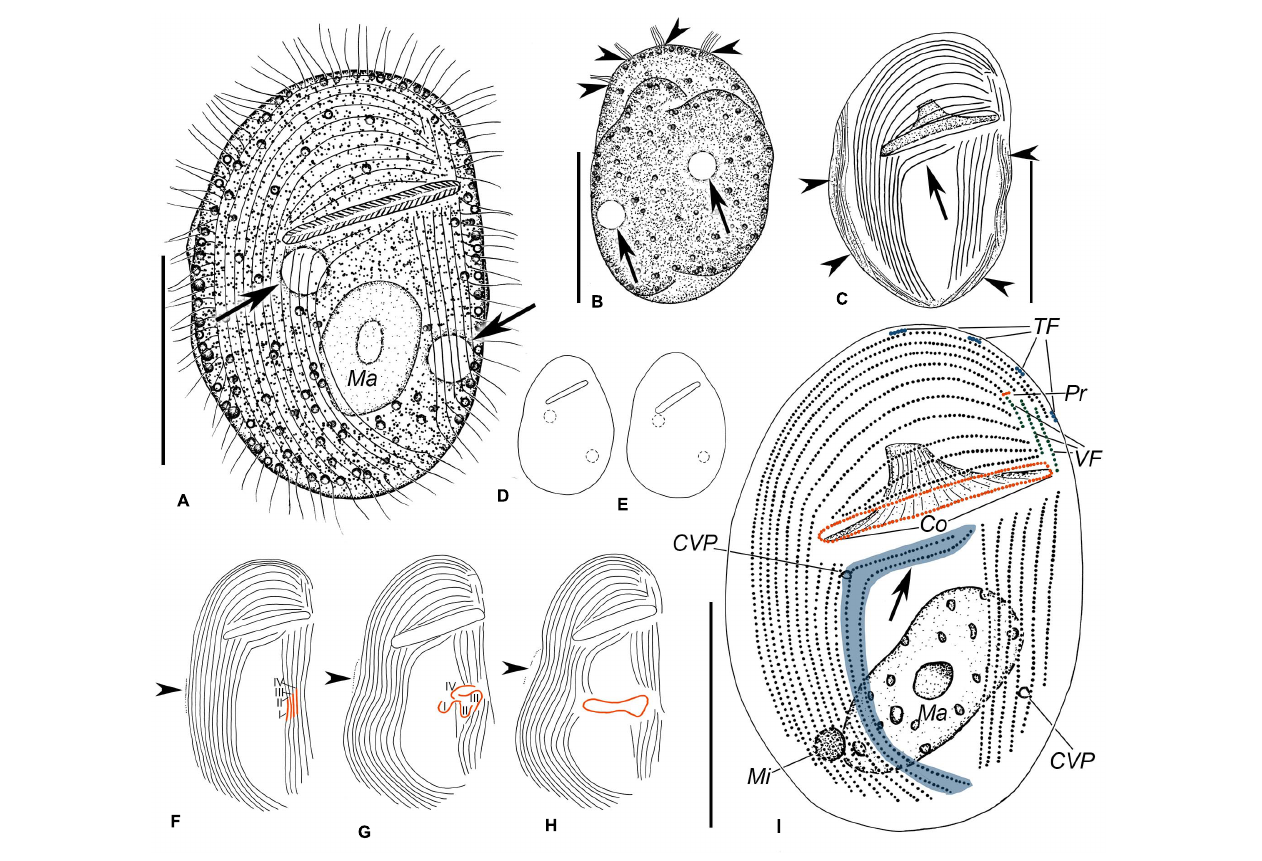
FIGURE 1 | Illustrations of Gastronauta paraloisi sp. n. from life (A,B,D,E) and after protargol-staining (C,F–I) . (A) Ventral view of a representative specimen. Arrows mark contractile vacuoles. (B) Dorsal view. Arrows indicate contractile vacuoles and arrowheads point to terminal fragments. (C) Ventral view of general ciliature; arrowheads denote the fibers along the cell margin after protargol-staining, and arrow shows the two curved postoral right kineties. (D,E) Body shape variations. (F–H) Several stages of morphogenesis. (F) Is an early stage, (G) is a middle stage, and (H) represents a late stage. Arrowheads indicate the equatorial fragment. I–IV represent anlagen I–IV. (I) Ventral overview of the ciliature. Arrow shows the two anteriorly curved right kineties, and special structures of Gastronauta are highlighted with different colors. Co, circumoral kinety; CVP, contractile vacuole pore; Ma, macronucleus; Mi, micronucleus; Pr, preoral kinety; TF, terminal fragments; and VF, vertical fragments. Scale bars: 30 µ